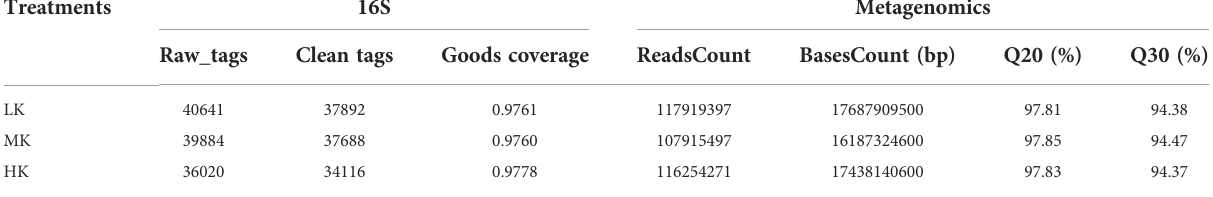
TABLE 2 Sequencing results of soil